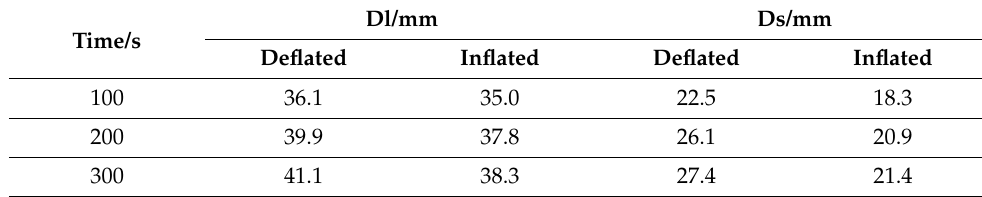
Table 9. Simulation data (ablation power 40 W).